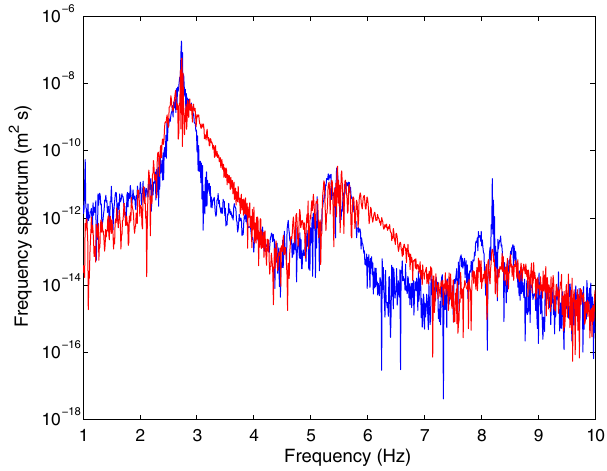
FIG. 5. Spectral profiles of the surface elevation at the last stage of the experiment shown in Fig. 4 at x ¼ 1 m (red curve) and at x ¼ 9 m (blue